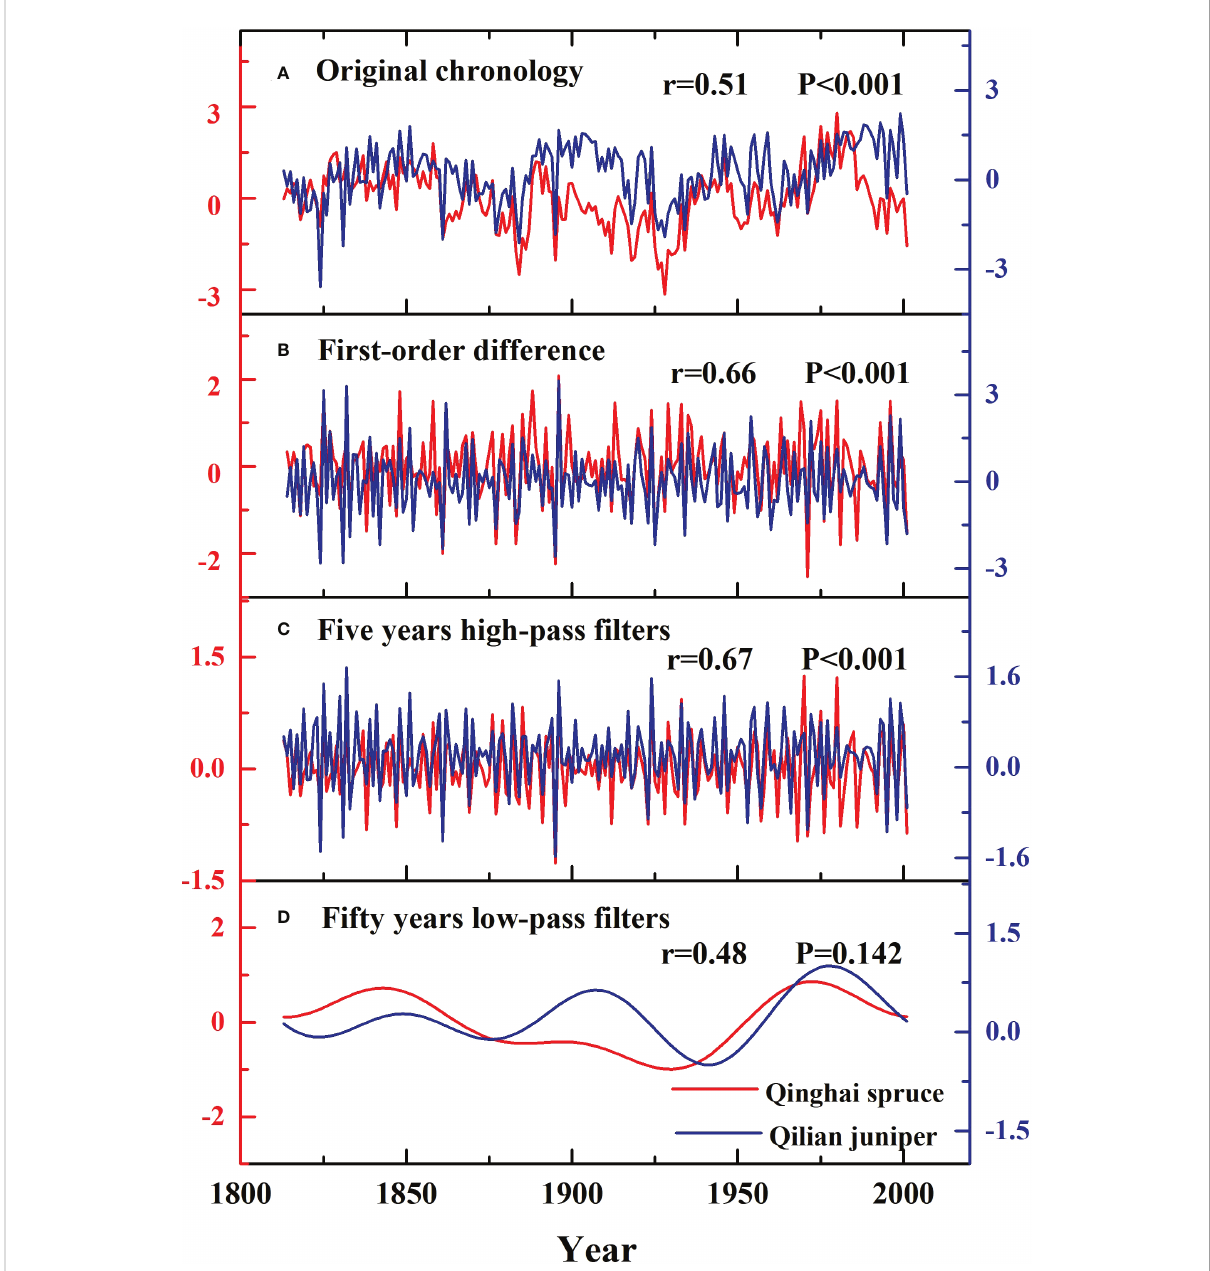
FIGURE 7 Comparison of the standard chronologies of Qinghai spruce (red lines) and Qilian juniper (blue lines) during the past 189